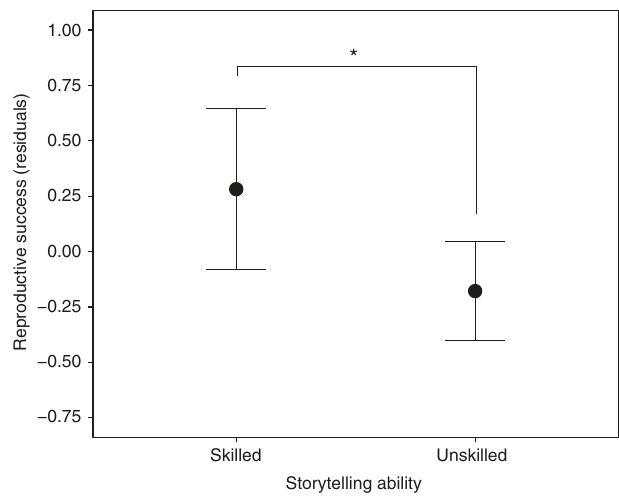
Fig. 2 Reproductive success and storytelling ability. Results of the mixed- effects linear regression model, indicating that reproductive success, based on number of living offspring, was greater in skilled storytellers ( n = 125) relative to less-skilled storytellers ( n = 199; b = 0.53, 95% CI: [0.10; 0.96], p = 0.016). Residuals control for age, age-squared, sex and camp. Error bars represent 95% con fi dence